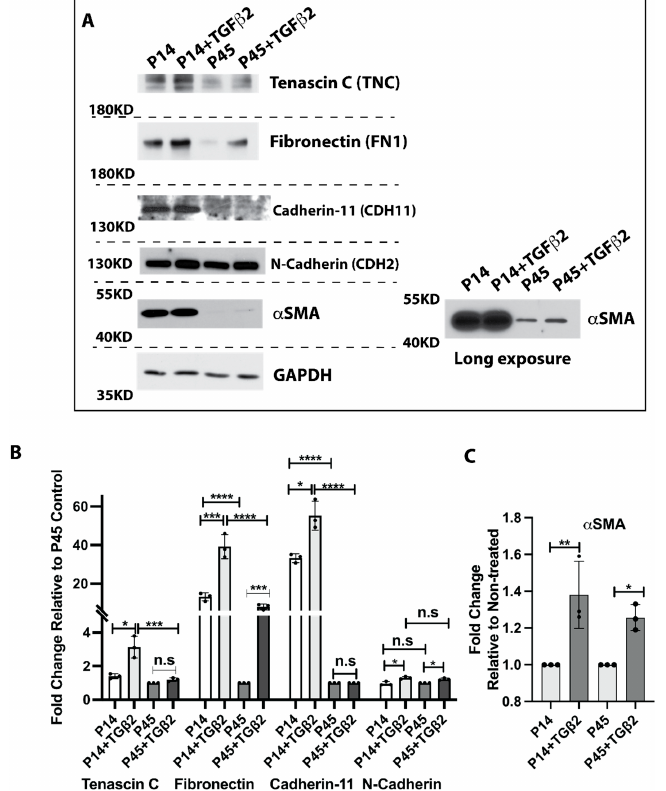
Figure 5. Aged LECs mitigate TGF β 2-mediated EMT. Passage 14 and 45 FHL124 cells were treated with 10 ng/mL TGF β 2 for 24 h. ( A ) Protein levels of fibronectin, cadherin 11, tenascin C, N-cadherin, and α SMA were determined by immunoblot assay of both P14 and P45 passage FHL124 cells with and without TGF β 2 treatment. A long exposure image of α SMA was included to measure α SMA expression in P45 passage cells. ( B ) Semi-quantitative results of tenascin C, fibronectin, cadherin 11, and N-cadherin protein expression. Data are expressed as fold change relative to P45 non-treated cells (control). ( C ) Semi-quantitative results of α SMA protein expression. Data are expressed as fold change relative to non-treated cells of the same passage. ( B , C ) Results are expressed as mean ± SD and were analyzed using one-way ANOVA with Tukey’s multiple comparisons test. Only p < 0.05 is considered significant. * < 0.05, ** < 0.01, *** < 0.001, **** < 0.0001; n.s, not significant.